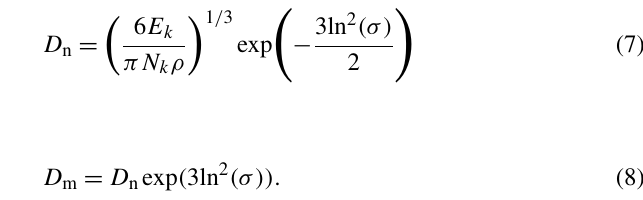
precipitation for each mode is described by an expression analogous to Eq.